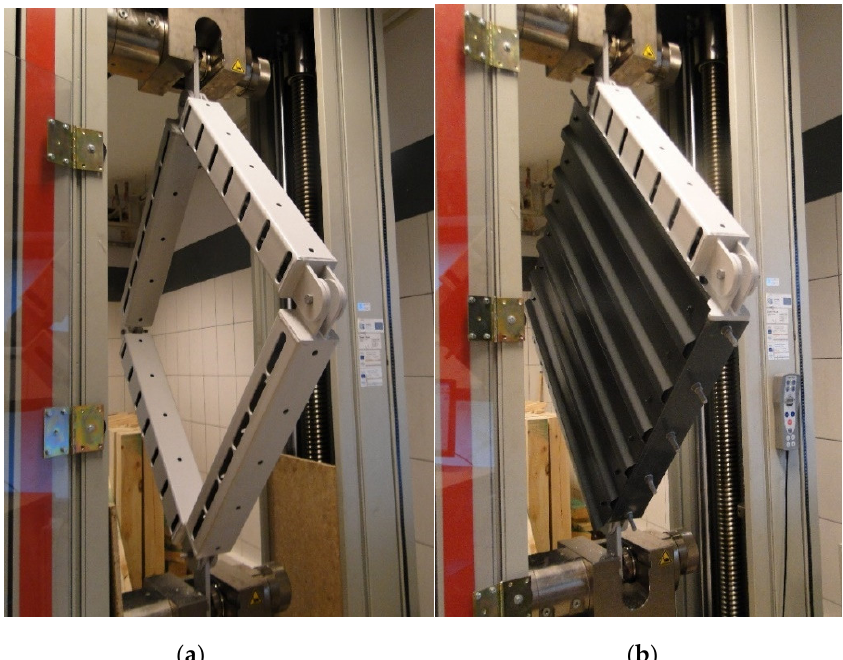
Figure 2. Experimental set-up: ( a ) permanent elements, ( b ) set-up with the analysed sheeting.